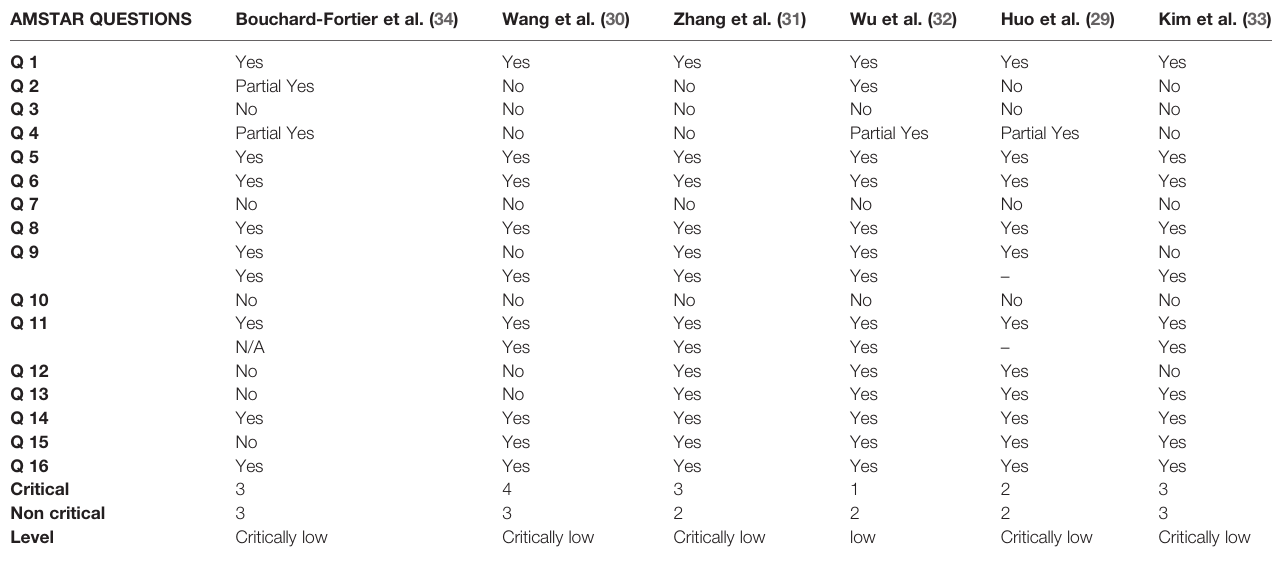
TABLE 2 | Findings of the AMSTAR quality